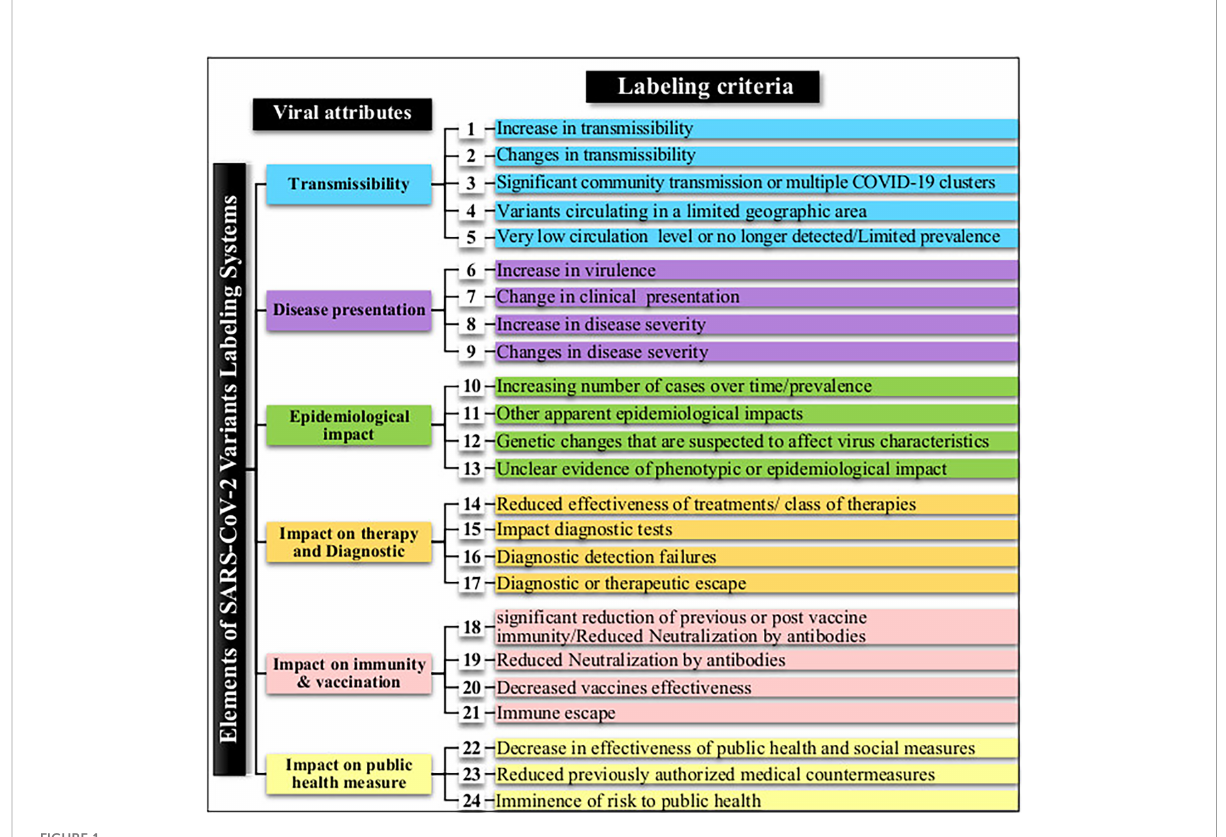
FIGURE 1 SARS-CoV-2 variant attributes and derived criteria used by the World Health Organization (WHO) and the Centers for Disease Control and Prevention (CDC) for the labeling of emergent